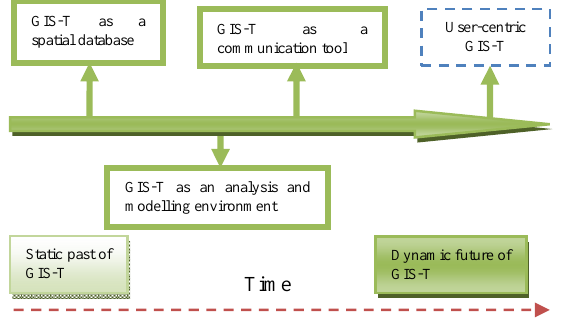
Figure 3: GIS-T from past